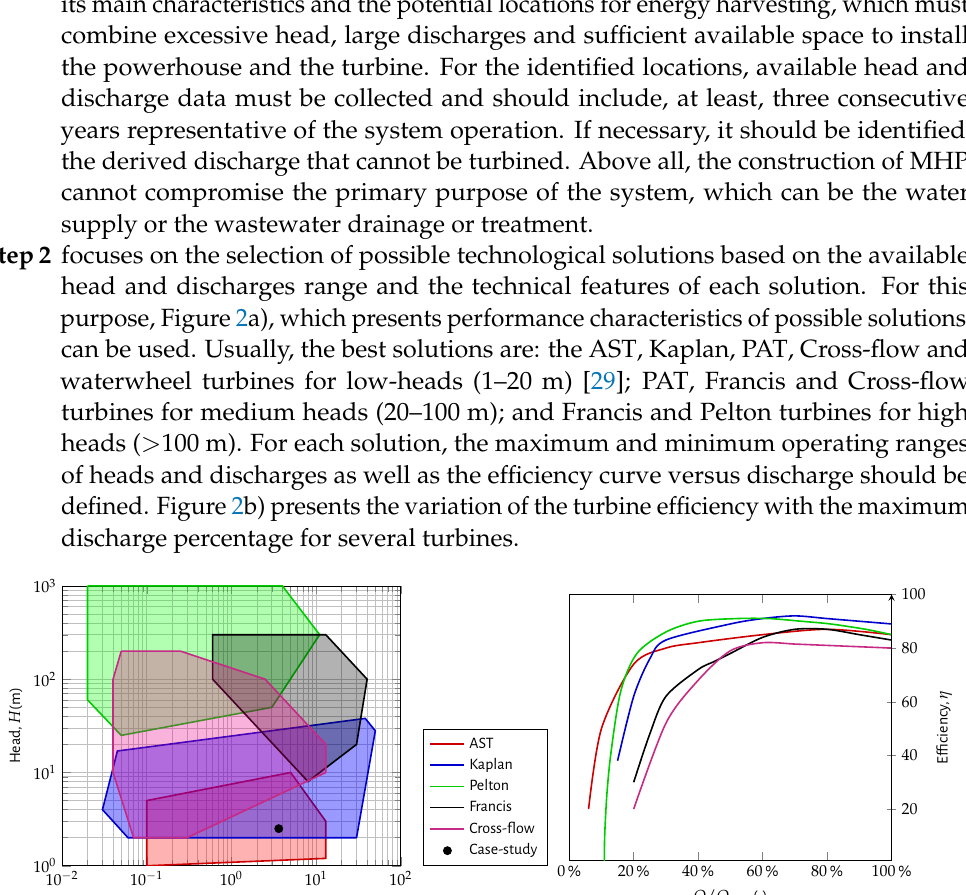
Figure1. Proposedmethodologyforenergyharvestingassessmentandtechnologyselection. Figure 1. Proposed methodology for energy harvesting assessment and technology selection. 78 Step1 consists of identifying the primary purpose of the water supply or collectors system, its main 79 characteristics and the potential locations for energy harvesting, which must combine excessive head, 80